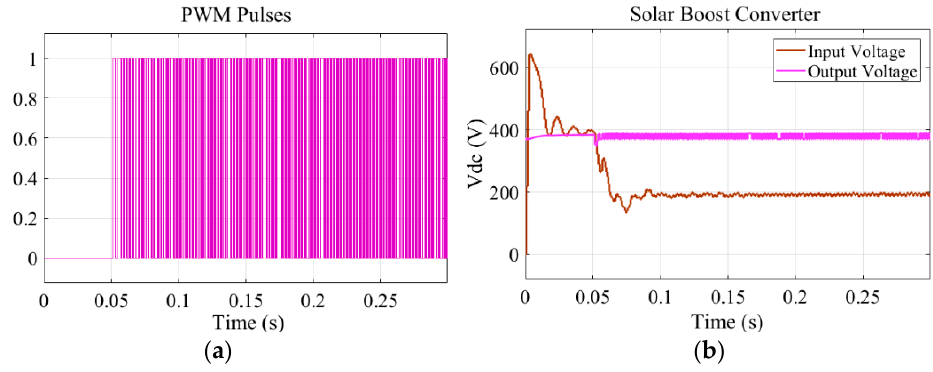
Figure 9. ( a ) PWM pulse. ( b ) Converter input and output voltage of PV.